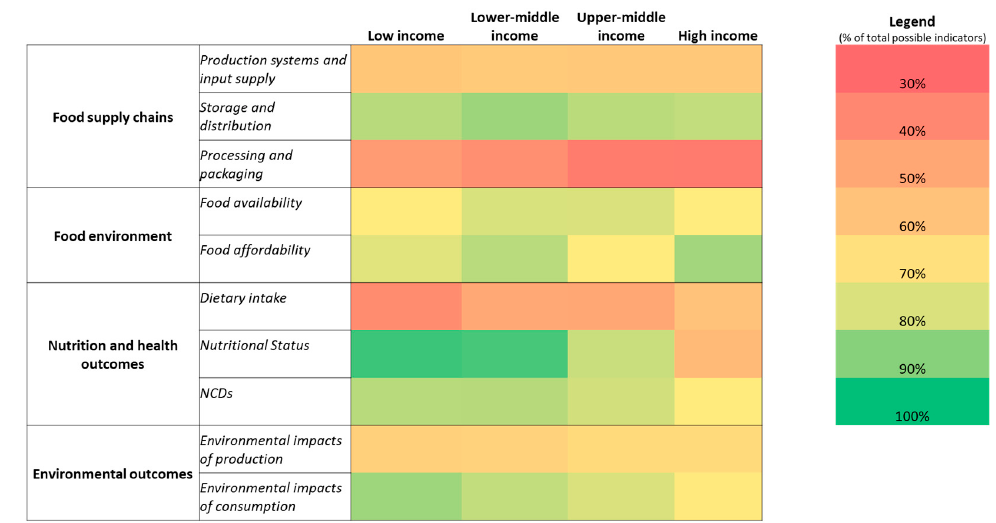
Figure 3. FSD data availability by income group. Note that Figure 3 does not include all sectors and sub-sectors included in the FSD.